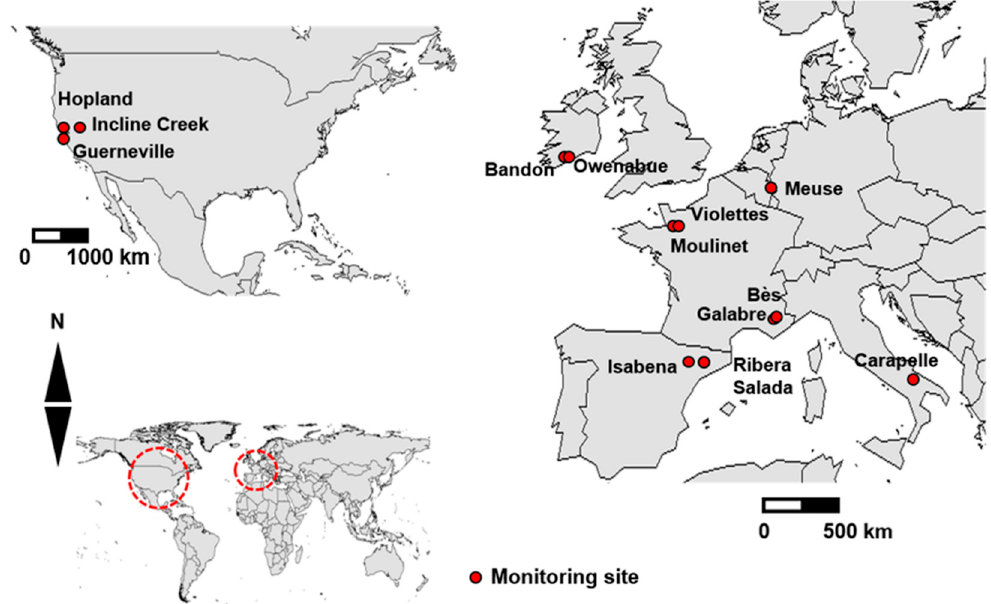
Figure 1. Location of the monitoring sites (see Table 1 and Table S1 for details of the catchments).